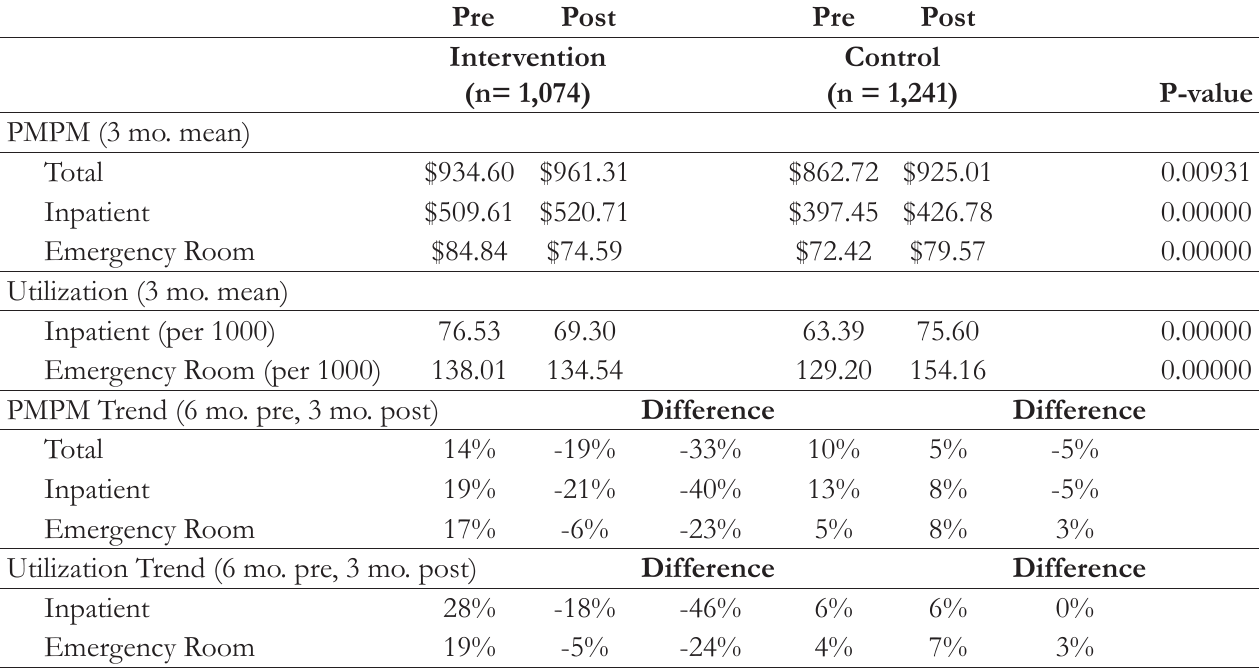
Table 2a. Unadjusted PMPM Costs, Utilization and Trends